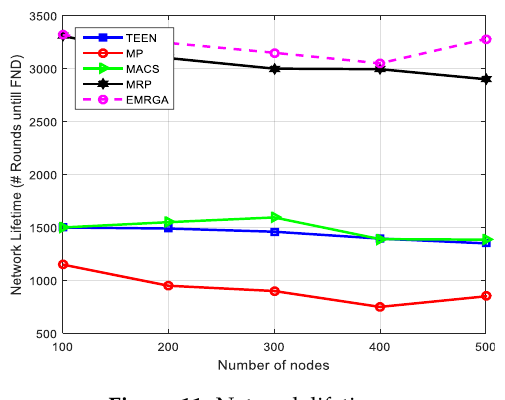
Figure 11. Network lifetime. Figure 12. Average energy.